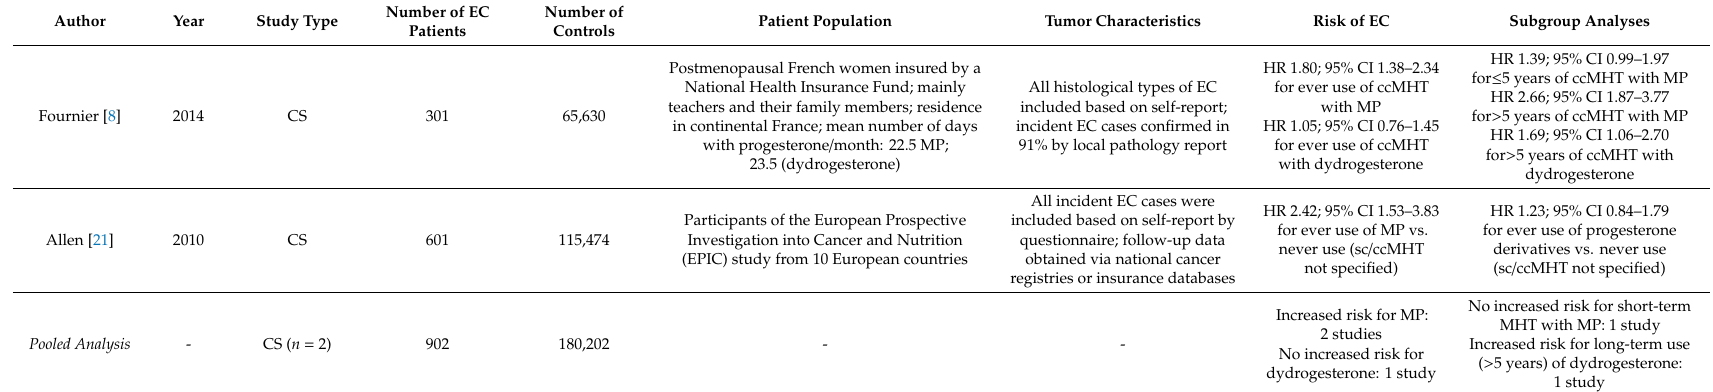
Table 3. Clinical Characteristics of Studies Reporting on ccMHT or scMHT with Progesterone or Dydrogesterone and EC Risk.